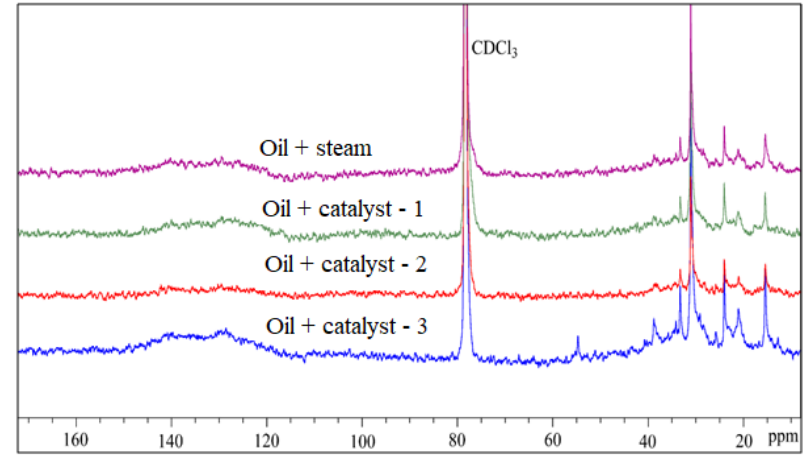
Figure 10. 13 C NMR spectra of resin fractions of original and upgraded oil.